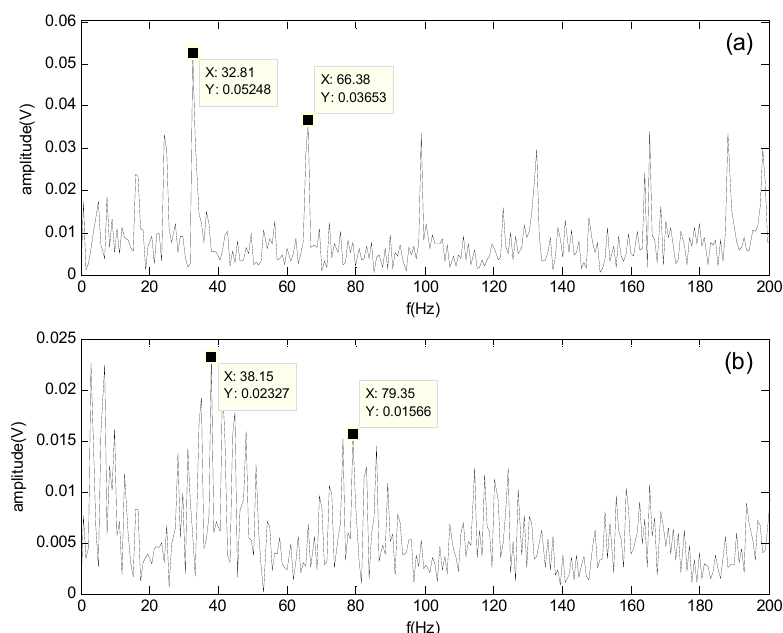
Figure 11. Spectrum of the separated signals obtained by the proposed method at 500 rpm: ( a ) Spectrum of the outer-race defect; ( b ) Spectrum of the roller defect.